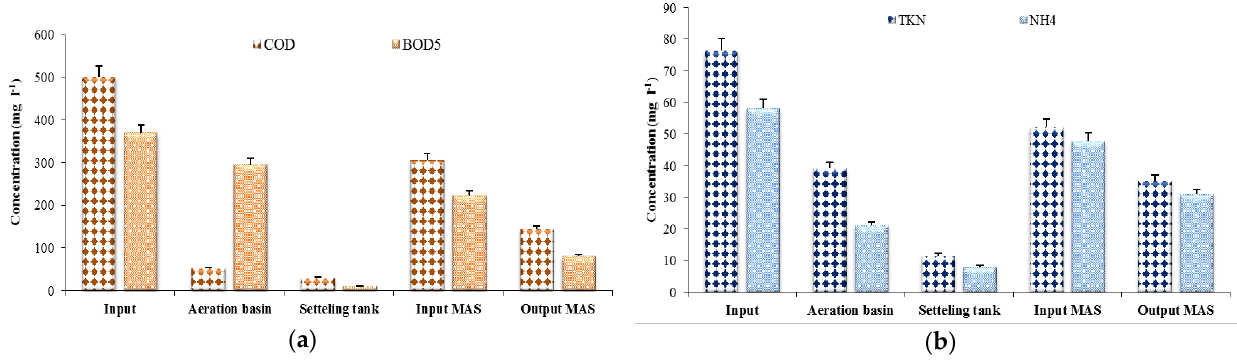
Figure 2. Organic matter and nutrient load evaluation from both systems: ( a ) BOD5 and COD evo- lution in conventional and eco-efficient systems; ( b ) TN and NH 4+ evolution in both systems during evolution in conventional and eco-efficient systems; ( b ) TN and NH + this experiment. during this